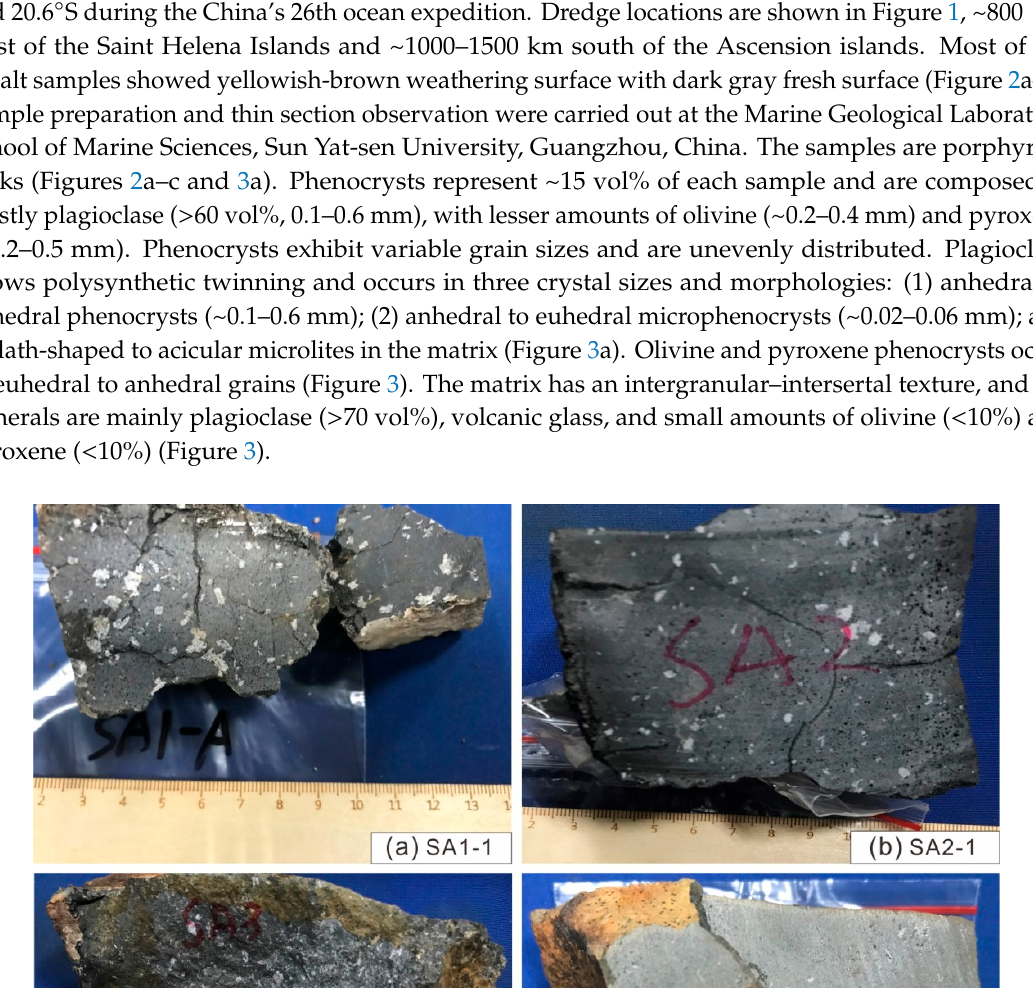
Table 1. Sample dredged locations and depths.